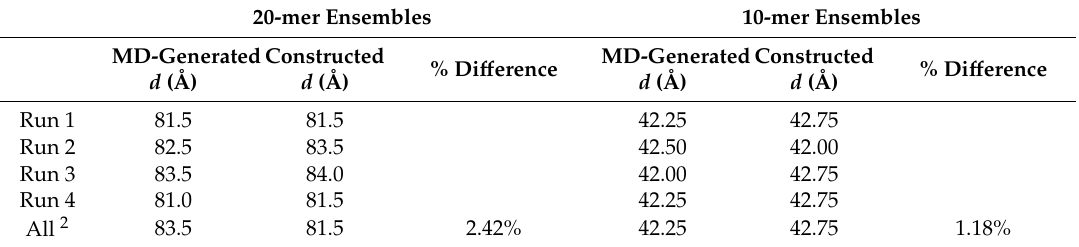
Figure 8. End-to-end distance probability distribution of MD-generated nonsulfated dermatan 20-mer ensemble; each of the four runs includes 10,000 conformations; probabilities were calculated for end-to-end distances sorted into 0.5 Å bins. Table 3. Most Probable End-to-End Distances ( d ) in MD-Generated and Constructed Nonsulfated Dermatan Ensembles 1 .